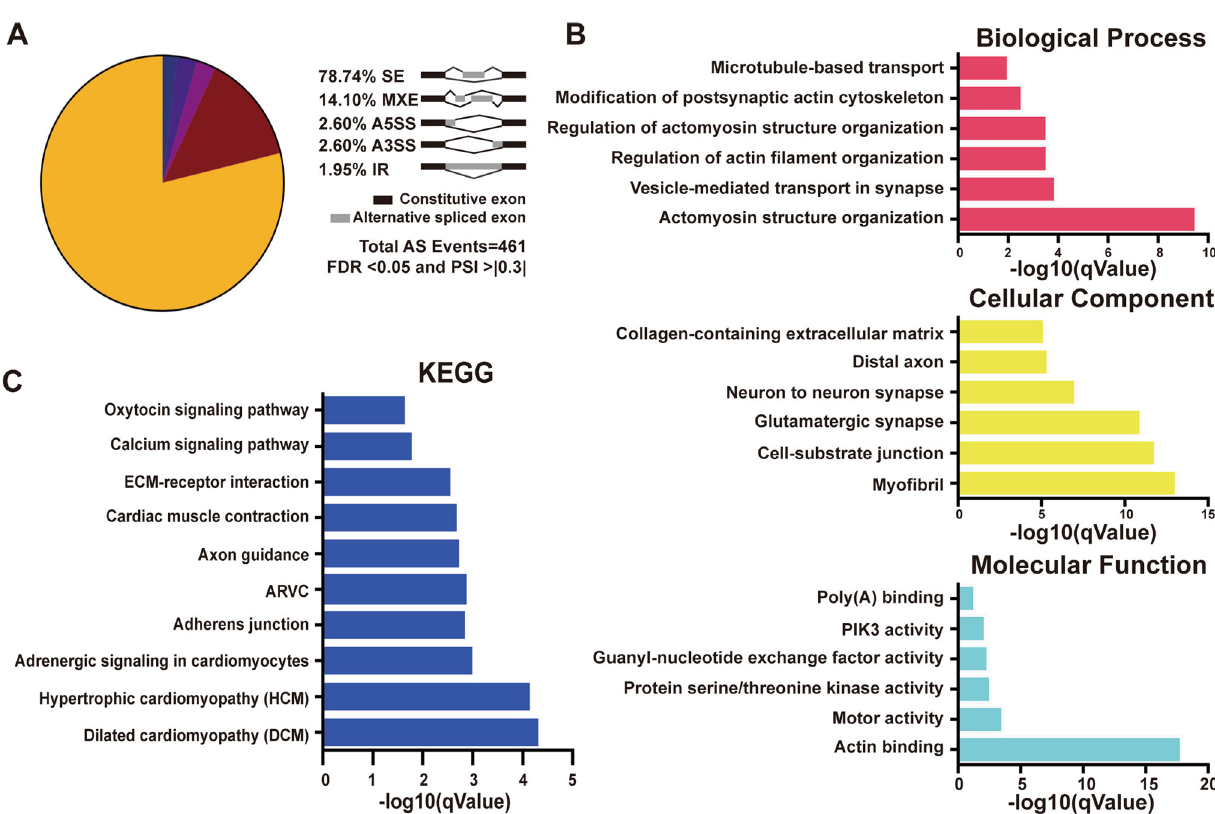
Fig. 5 Analysis of differential alternative splicing events in hESC and hESC- QKI del differentiated cardiomyocytes at Day-15. A Schematic diagram shows the overall distribution of alternative splicing events in hESC- QKI del differentiated cardiomyocytes. B Enrichment analysis of differentially spliced genes using Gene Ontology (GO) and C KEGG pathway databases. GO enrichment and KEGG pathway enrichment analysis of differentially expressed genes were performed, respectively, using R programming based on the